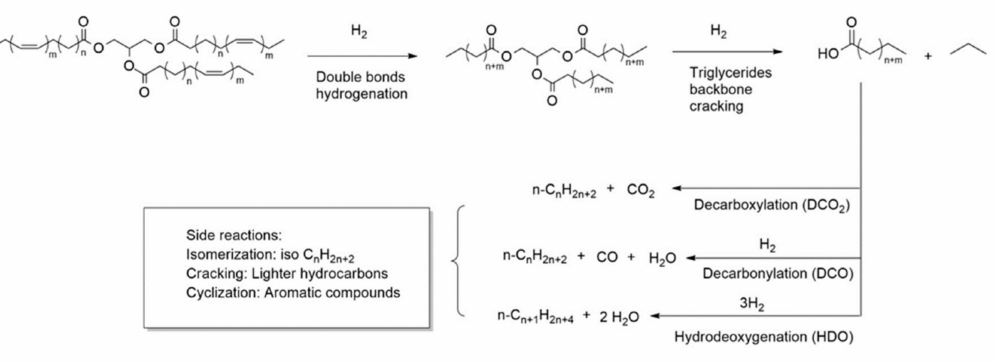
Figure 3. Reaction pathway of hydroprocessing using vegetable oil to produce renewable diesel [23]. Adapted with permission from ref. [23]. 2019